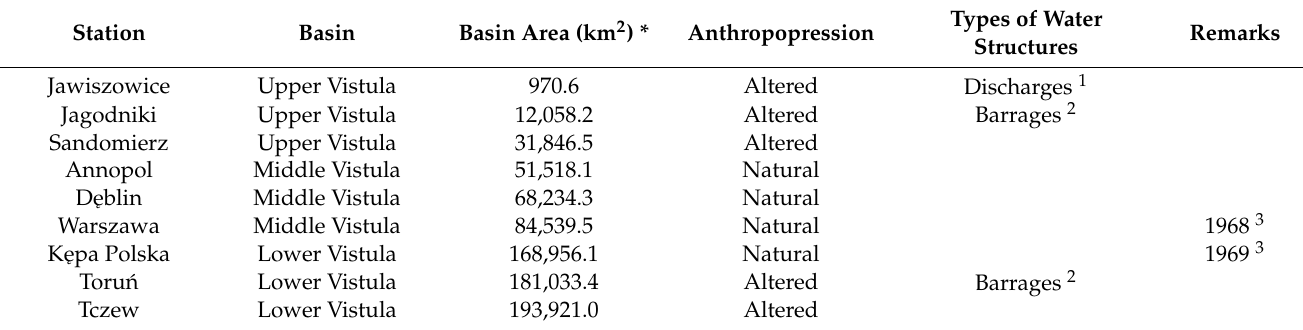
Table 2. The list of hydrological stations along the course of the Vistula River used in the study in continuous operation since